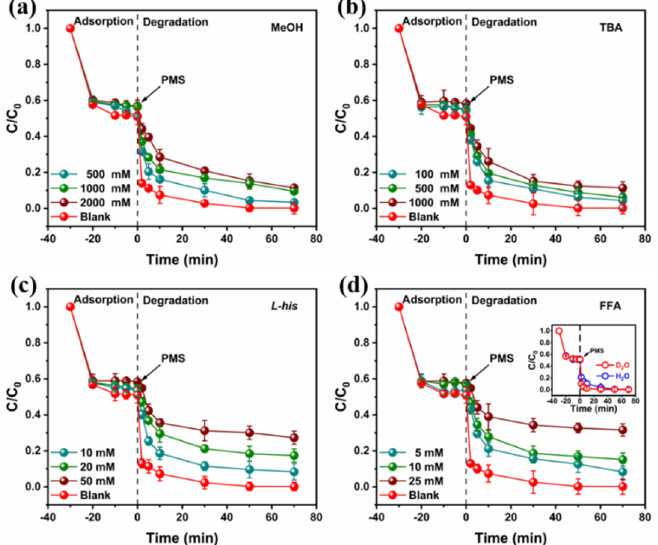
Figure 4. The effects of several quenching agents (i.e., MeOH ( a ); TBA ( b ); L-his ( c ); and FFA ( d )) on BPA removal in SPFC800/PMS system and the solvent exchange experiments (inset of d). (Experi-